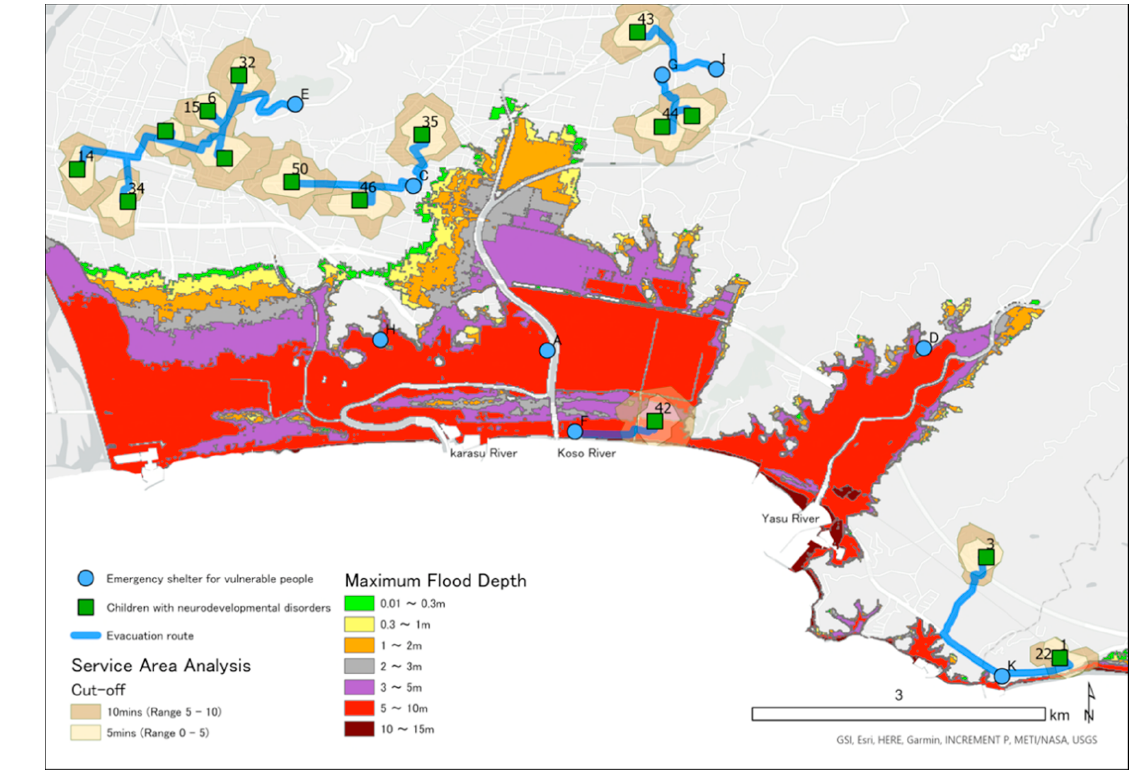
Figure 5. Service area analysis of emergency shelters for vulnerable people (ESVPs) in Aki and evacuation routes to nearby ESVPs. Table 2. Characteristics of ESVPs in the predicted inundation area.